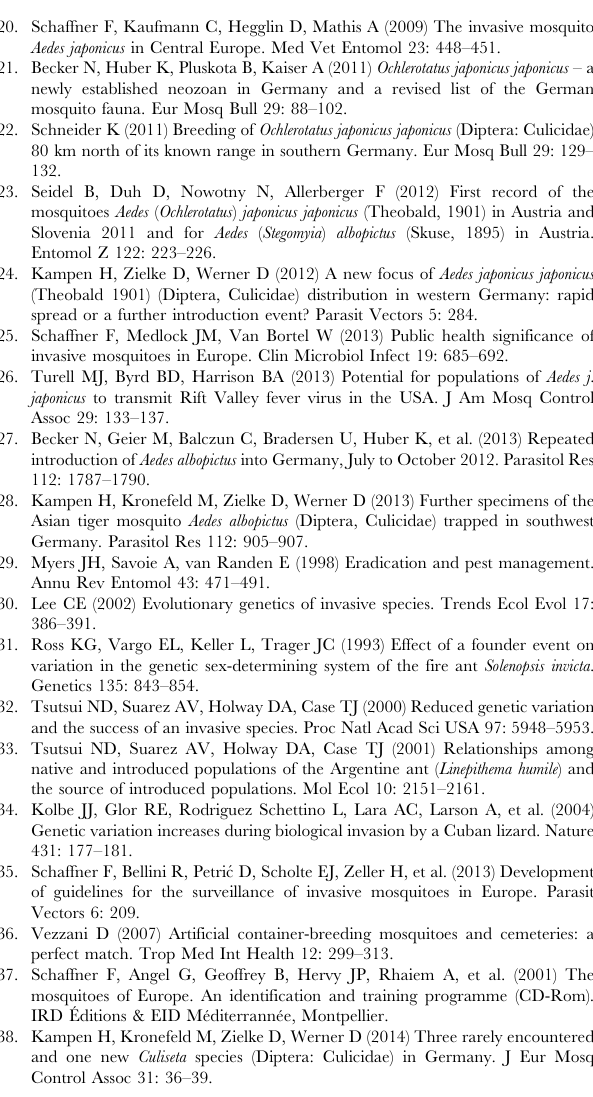
Figure S1 Results of a factorial correspondence analy- sis performed on individual genotypes in Genetix 4.05. Yellow squares and burgundy squares correspond to individuals from Belgium and Austria/Slovenia populations, respectively. Swiss specimens are shown in dark blue, the remaining colors (light blue, pink, green, grey and white) are from German populations. These results mirror the results of the